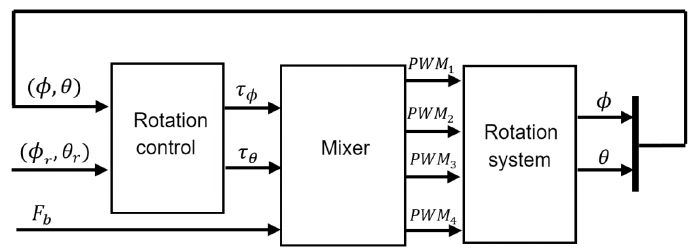
Figure 12. Integration of Mixer block to the control scheme for rotation